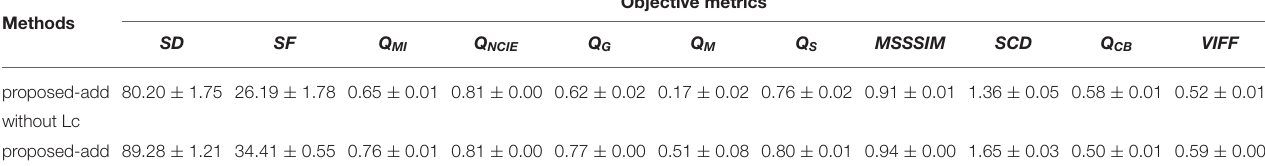
TABLE 3 | The quantitative evaluation of the proposed method (addition strategy) without and with L c on the MRI-PET dataset. Methods